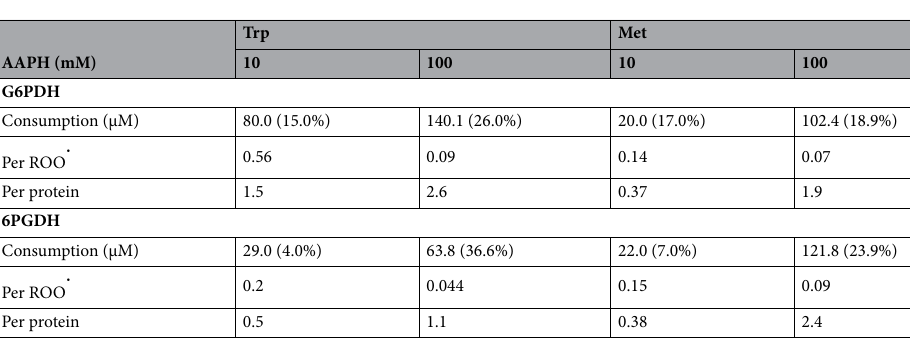
· Table 1. AAPH-derived ROO affect the amino acid content of G6PDH and 6PGDH. Consumption of amino acids was assessed by OPA assay after incubation of G6PDH (54 μM) or 6PGDH (58 μM) with 10 and 100 mM AAPH for 180 min at 37 °C. Data are expressed as μM concentrations. The ratios of amino acid · consumption (μM) and the total dose of ROO generated into the system (0.144 or 1.44 mM for 10 or 100 mM AAPH), and protein concentration (μM), are presented. Such ratios give values meaning the moles of amino · acid consumption per mole of ROO , and per mole of protein, respectively. Values in parenthesis show the % consumption of each amino acid, taking the initial values as 100%. Data are the mean of at least three independent experiments each measured in triplicate. For ease of reading only the standard deviations of loss of enzymatic activity are